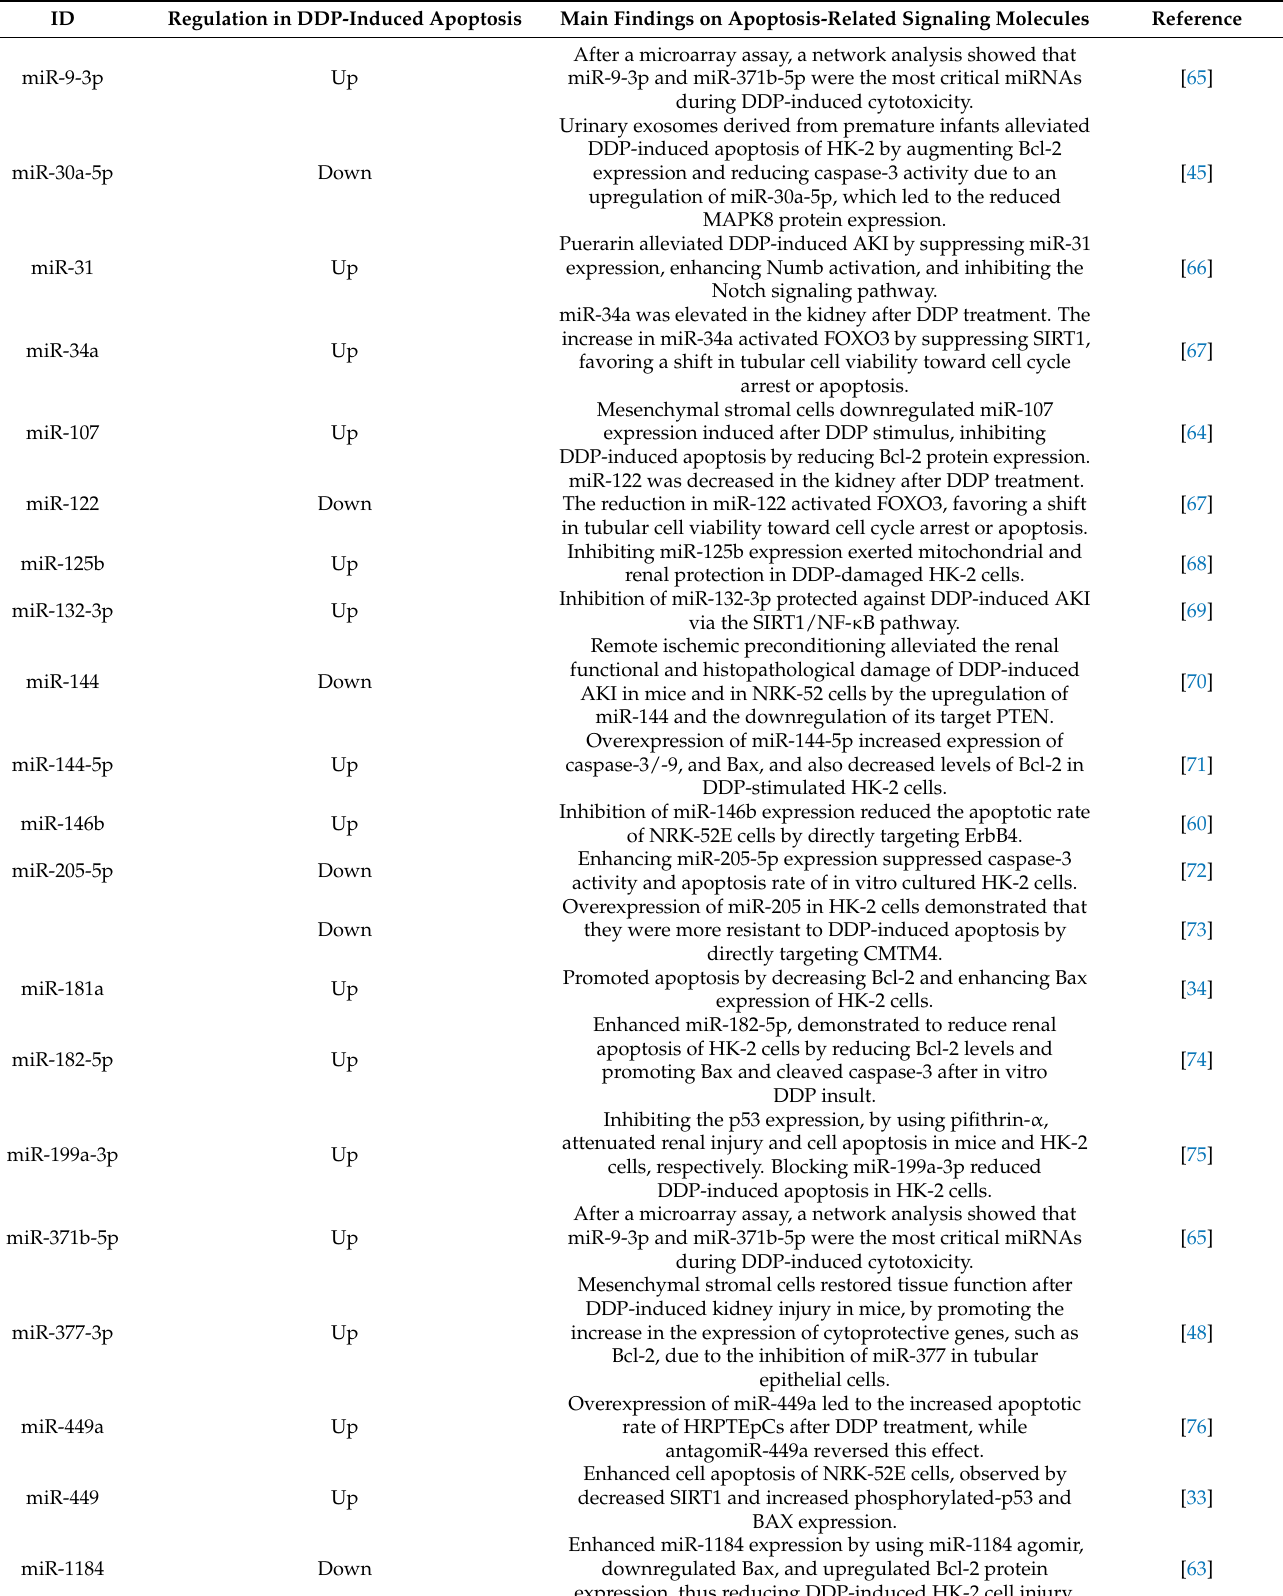
Table 1. MicroRNAs (miRNAs) involved in cisplatin (DDP)-induced apoptosis-related signaling